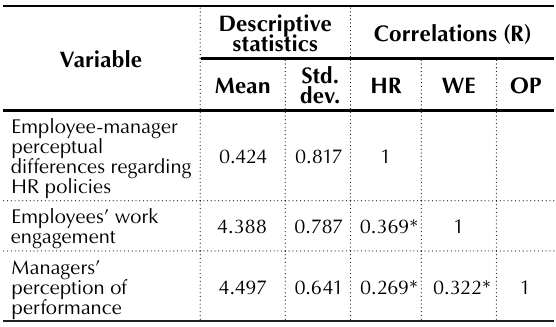
Table 3. Descriptive statistics and